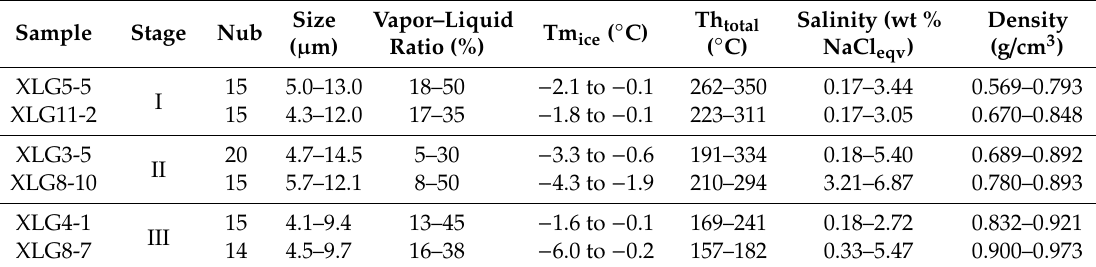
Table 1. Microtemperature measurements of the primary inclusions in di ff erent mineralization stages of exhalative-sedimentary periods from the Xialiugou